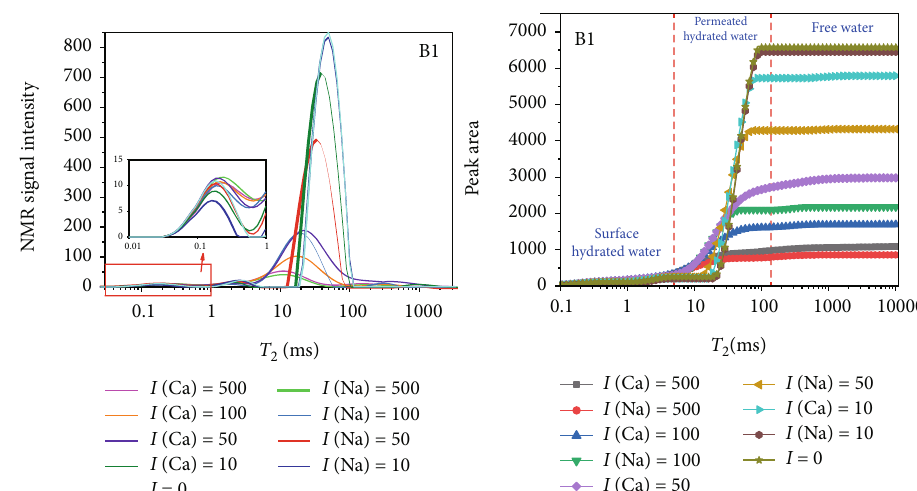
T 2 distribution of sodium-modi